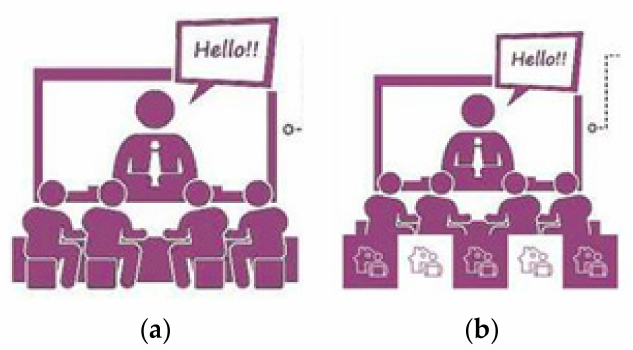
Figure 5. ( a ) Face-to-face modality ( b ) Mixt modality.